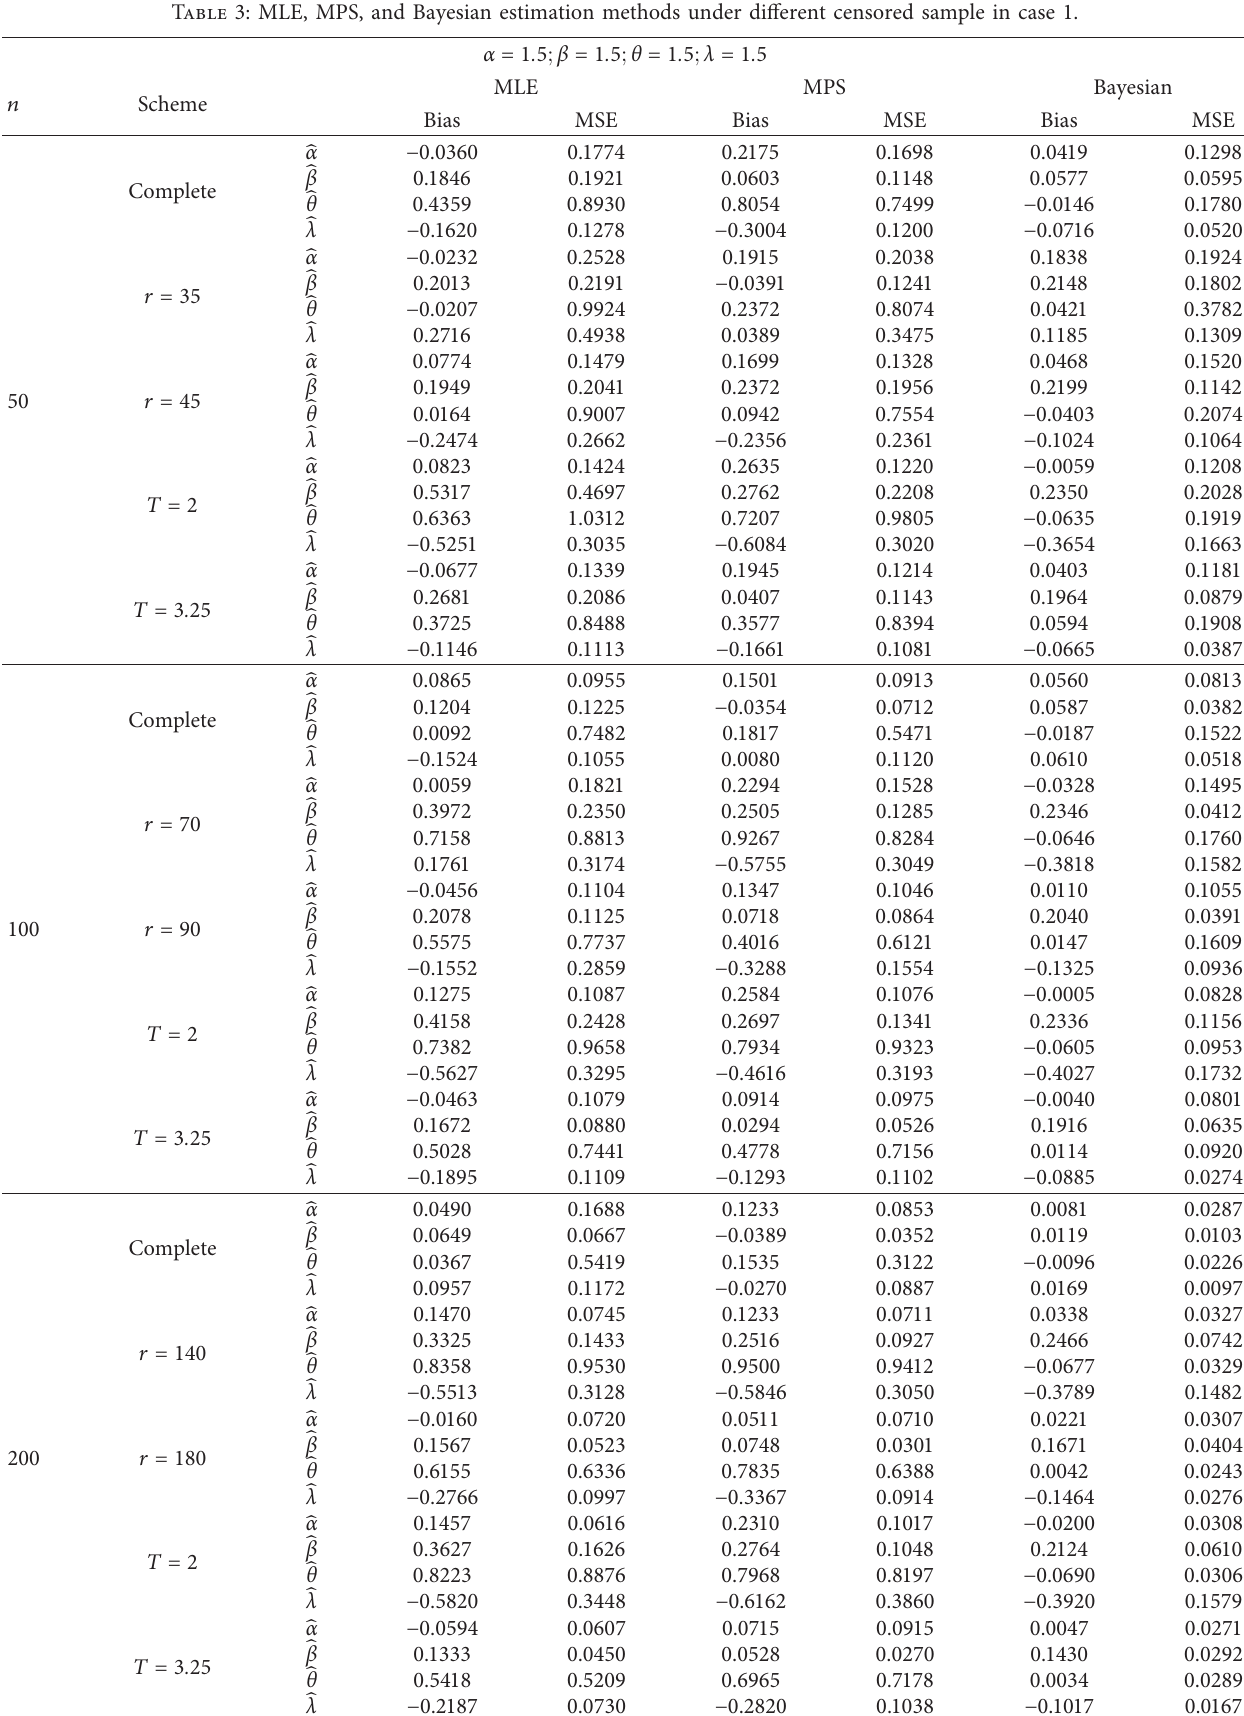
Table 3: MLE, MPS, and Bayesian estimation methods under different censored sample in case